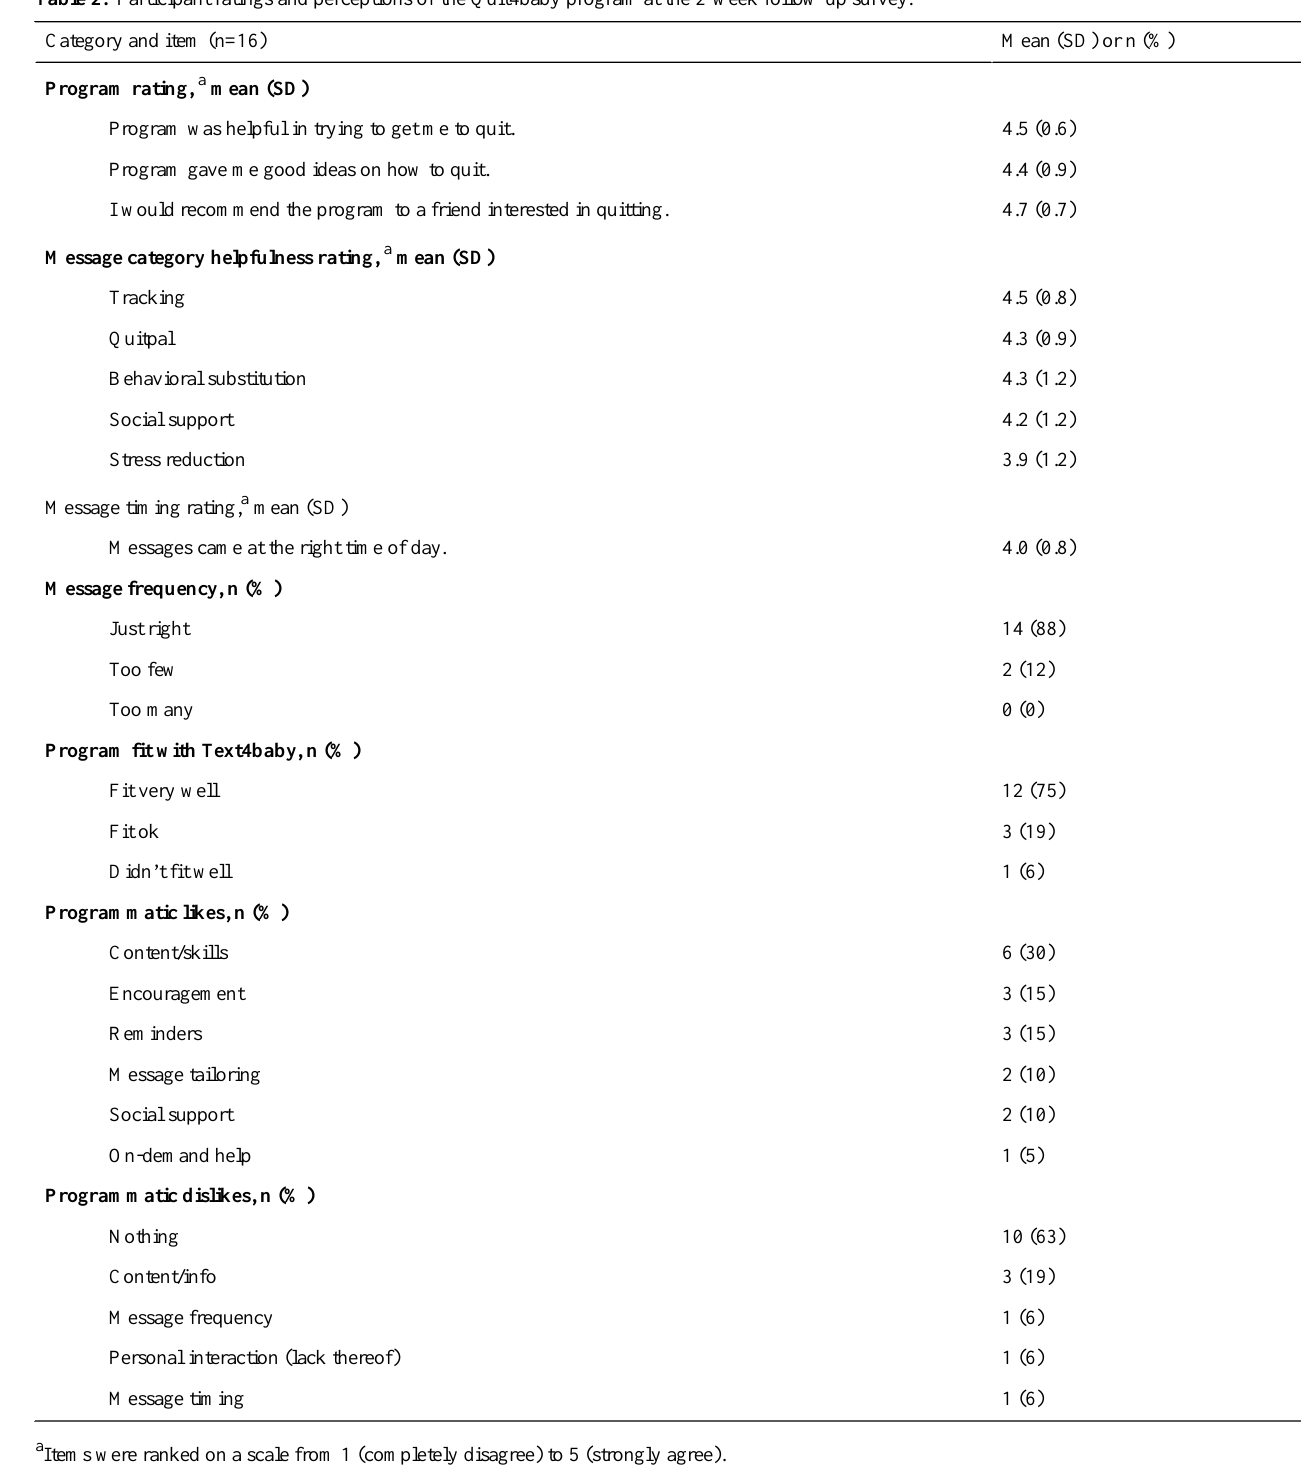
Table 2. Participant ratings and perceptions of the Quit4baby program at the 2-week follow-up survey.